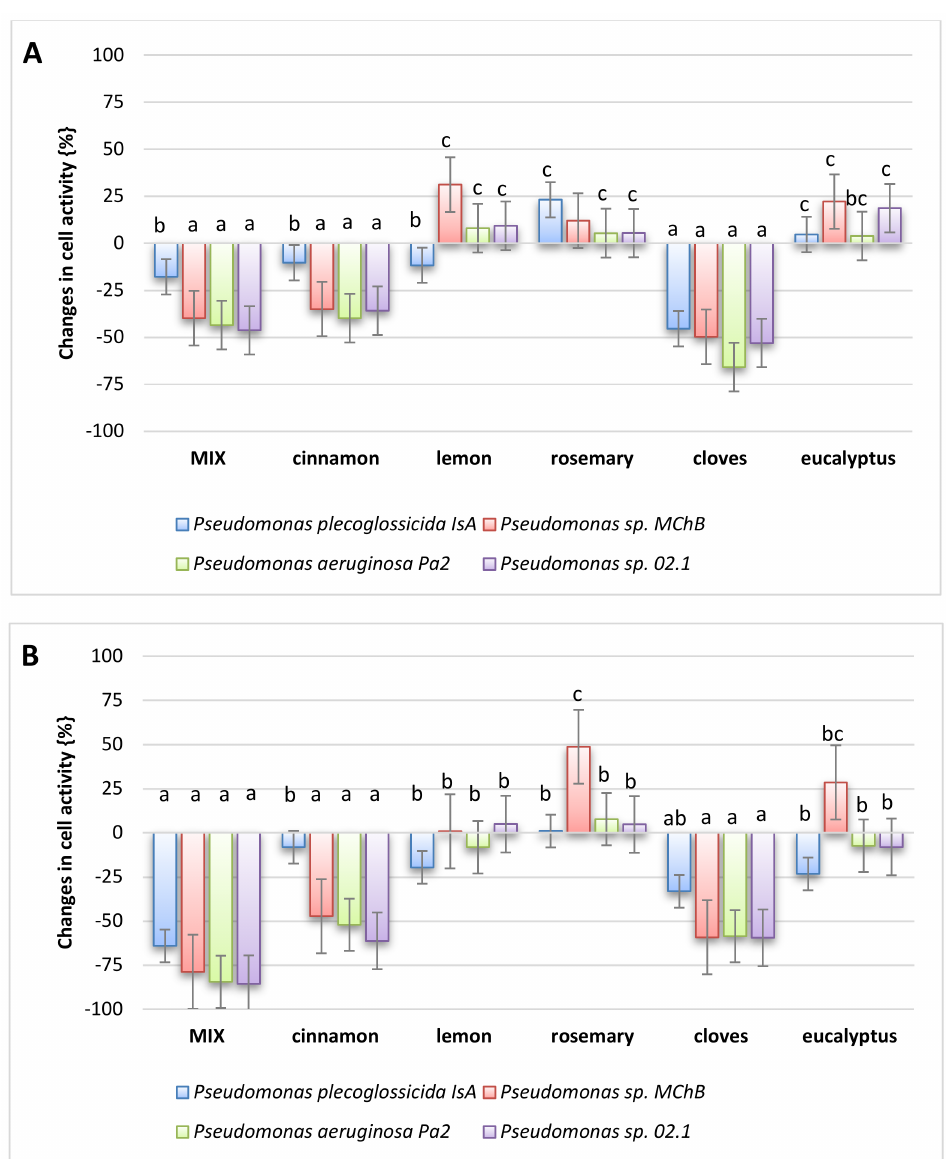
Figure 8. Changes in bacteria cell metabolic activity in ( A ) fresh oils, and ( B ) oils after 4 weeks. The different small letters indicate groups of the results that differ statistically